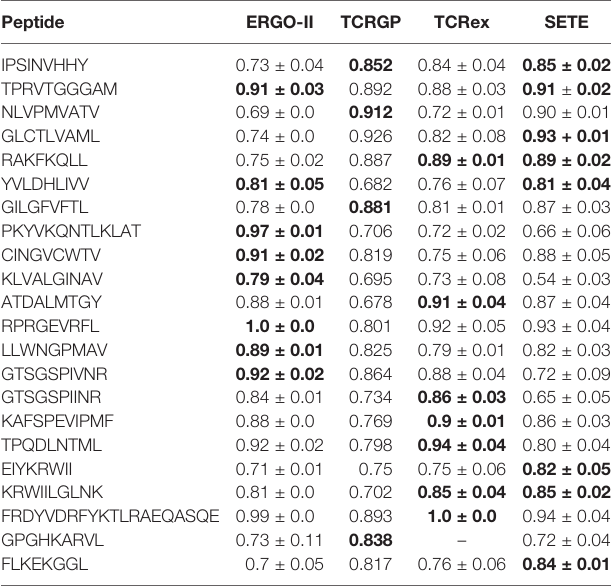
TABLE 5 | A comparison of ERGO-II model ’ s performance to those of other methods on the SPB task. Peptide ERGO-II